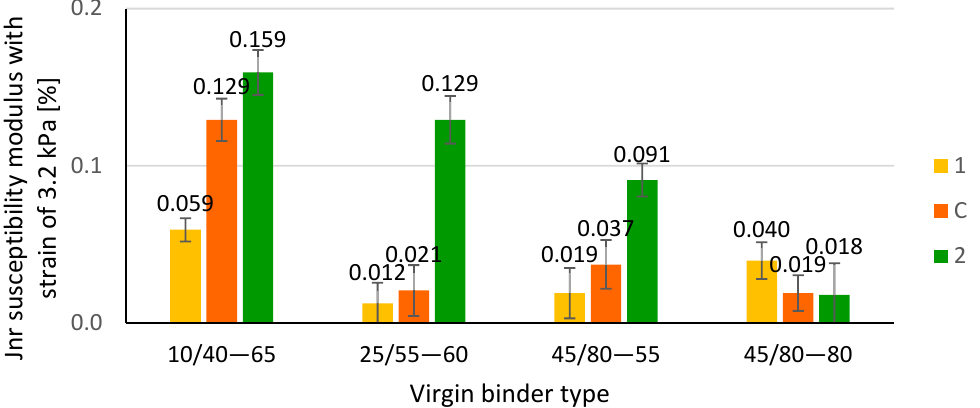
Figure 8. Percent recovery R at 3.2 kPa stress; 1—outer layer of binder film, 2—inner layer of binder film, C—complete blending.